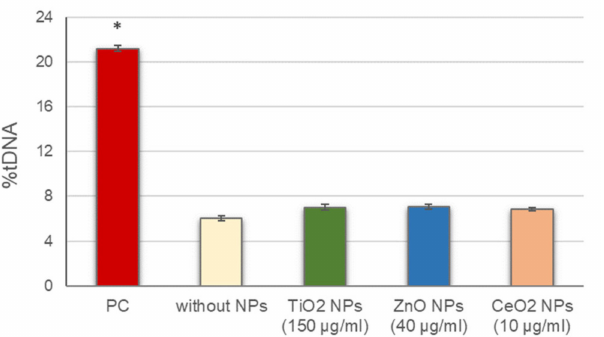
Figure 1. Assessment of NPs interference with the comet assay methodology. Columns represent mean values and error bars indicate the standard errors. PC: positive control (50 µ g/mL MMS for 3 h). * p < 0.01, significant difference with regard to without